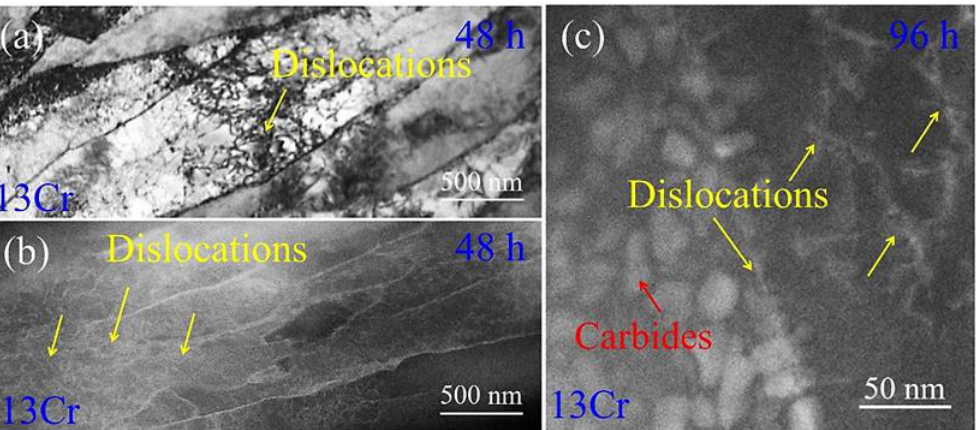
Figure 12. Deformation characterizations around dislocations in the as-crept 13Cr samples: ( a ) TEM BF image showing dislocation tangling in ferrite lath interior after creeping for 48 h and ( b ) HAADF STEM image showing atom segregation on dislocations; ( c ) HAADF STEM image of atom segregation on dislocations in the 96 h crept samples.